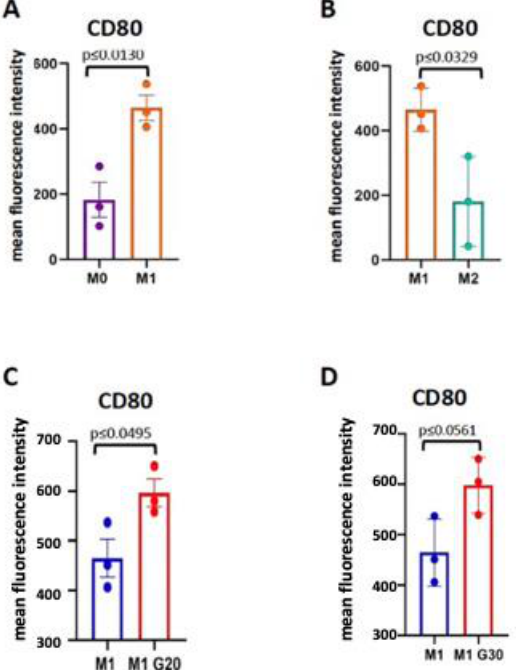
Figure 14. Specificity of expression of M1 marker CD80. ( A – D ) Comparison of CD80 expression levels between MO, M1, and M2 macrophages treated and untreated with gadolinium showed that the high expression of CD80 was specific for the M1 macrophages.